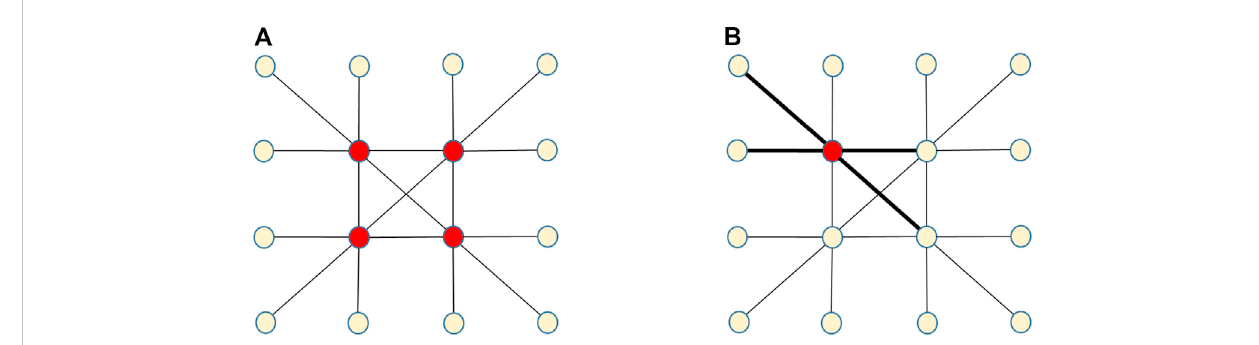
FIGURE 9 Node vaccination priority in social networks. (A) A binary network where the nodes to vaccinate (red nodes) are selected considering the node degree; in this network, the four red nodes show the same vaccination priority. (B) The weighted network counterpart of the binary network in ( A) ; in this network, the nodes to be vaccinated are ranked considering their strength. The node in red has the highest strength and the highest priority for vaccination. In the case of face-to-face networks in which link weights indicate the contact time between individuals, vaccinating the node sharing strong links would eliminate the most signi fi cant channels of